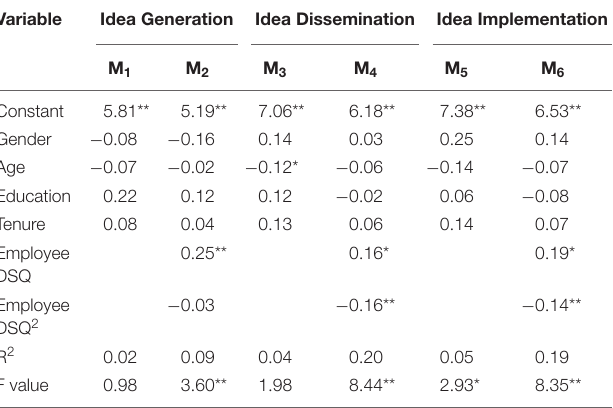
TABLE 3 | Results of hierarchical linear modeling-based regression analysis.